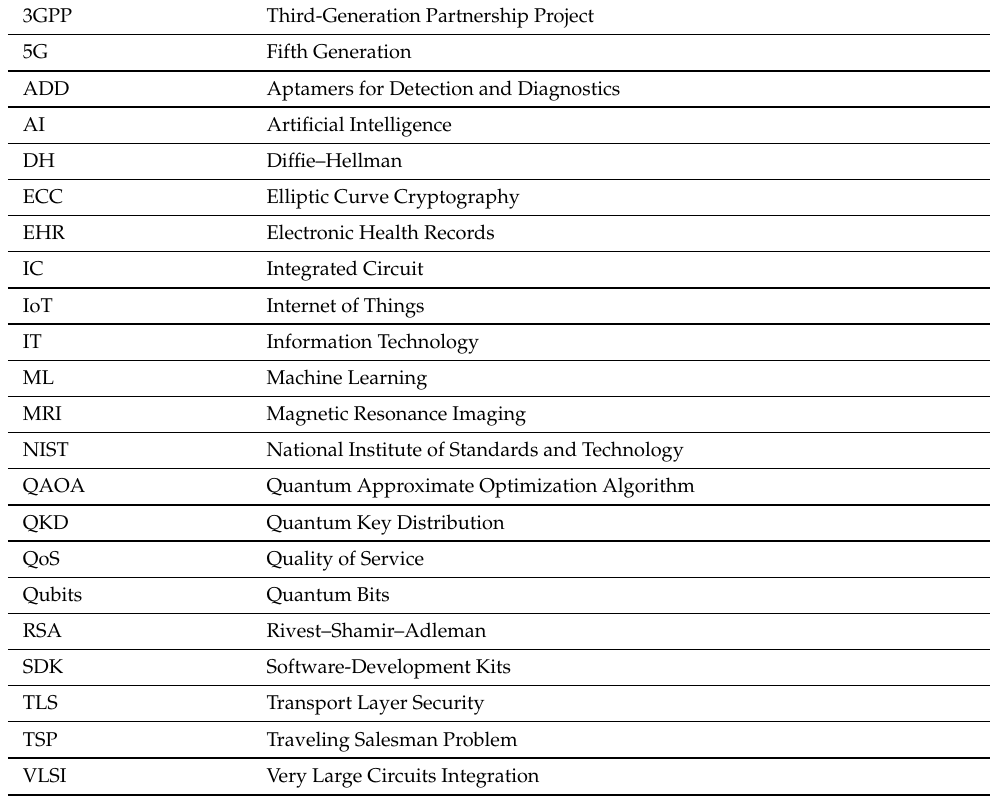
Table 2. List of acronyms and their